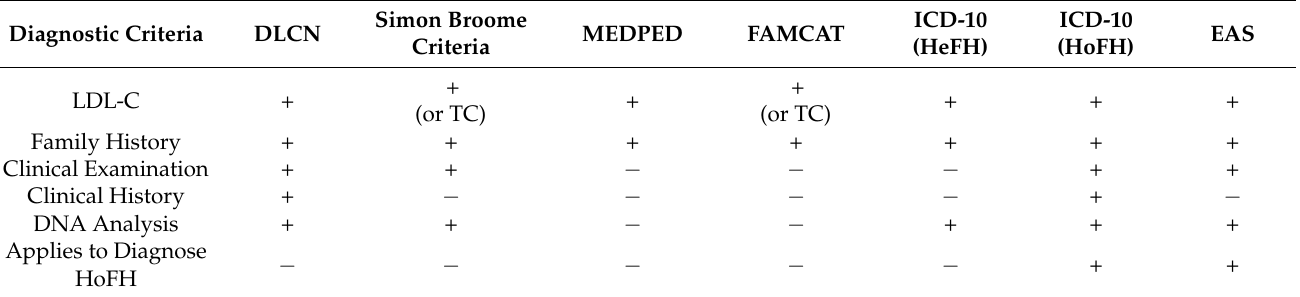
Table 2. Comparison of Familial Hypercholesterolemia Diagnostic Criteria